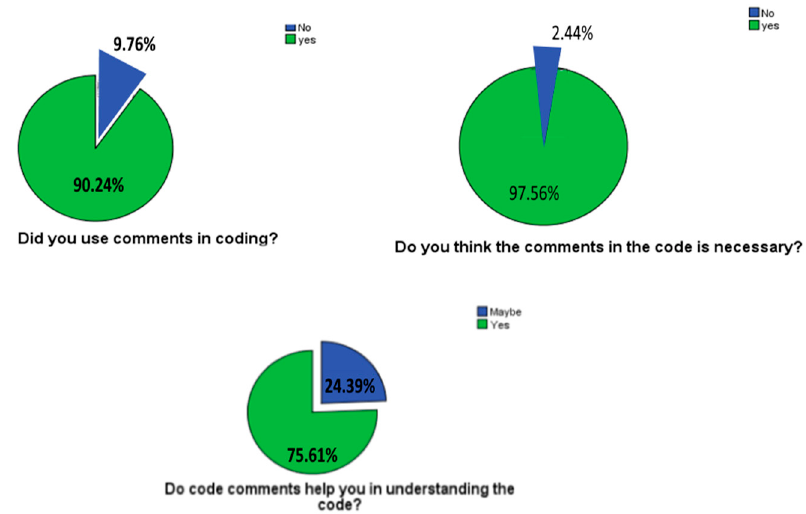
Figure 15. Result about source code comments.